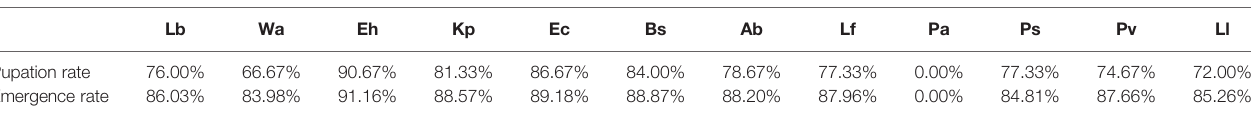
TABLE 2 | The impact of bacterial isolates on the pupation rate and emergence rate of the house fl y. Lb Wa Eh Kp Ec Bs